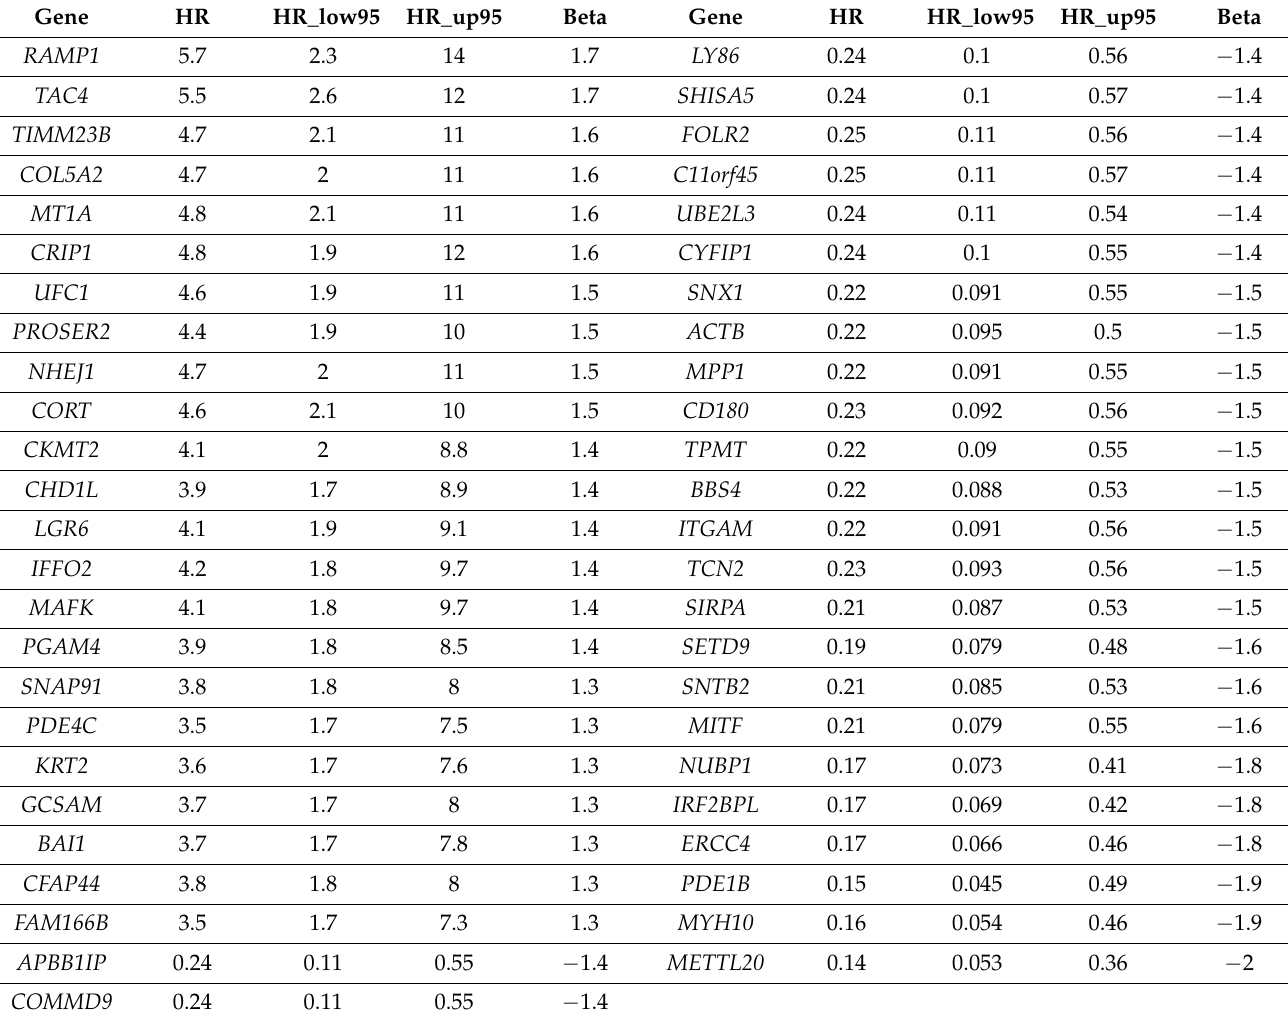
Table 1. List of the top 49 significant ( p -value < 0.001) genes found in survival analysis. The gene list is sorted based on beta values. HR: Hazard